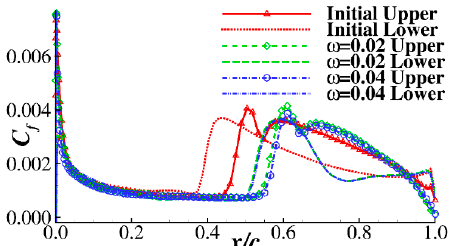
Figure 10. Friction coefficients of the initial and optimized airfoils. Energies 2020 , 13 , x FOR PEER REVIEW Table 4. Transition computations of the airfoils ( Ma = 0.73, Re = 6.5 × 10 6 ).